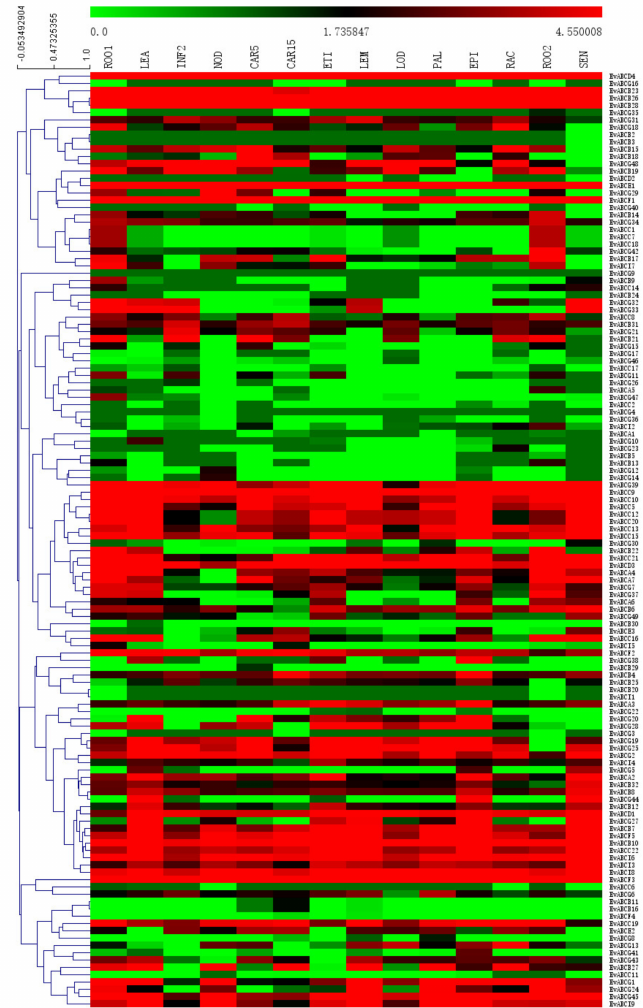
Figure 4. Heatmap showing the expression pattern of HvABC genes in developmental stages and tissues, including ROO1 (Roots from seedings), ROO2 (Roots), LEA (Shoots from seedings), ETI (Etiolated seeding, dark cond), INF2 (Developing inflorescences), PAL (Dissected inflorescences), LEM / LOD / RAC (inflorescences, lemma / lodicule / rachis), NOD (Developing tillers), CAR5 / CAR15 (Developing grain, 5 DAP / 15 DAP), EPI (Epidermal strips), SEN (Senescing leaves). The combined phylogenetic trees of HvABCs genes on the left panel. The scale bar at the top represents relative expression value. Red denotes high expression levels, and green denotes low expression